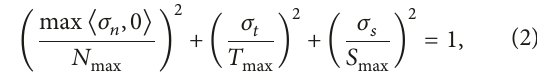
crack propagation. The quadratic stress failure criterion was expressed